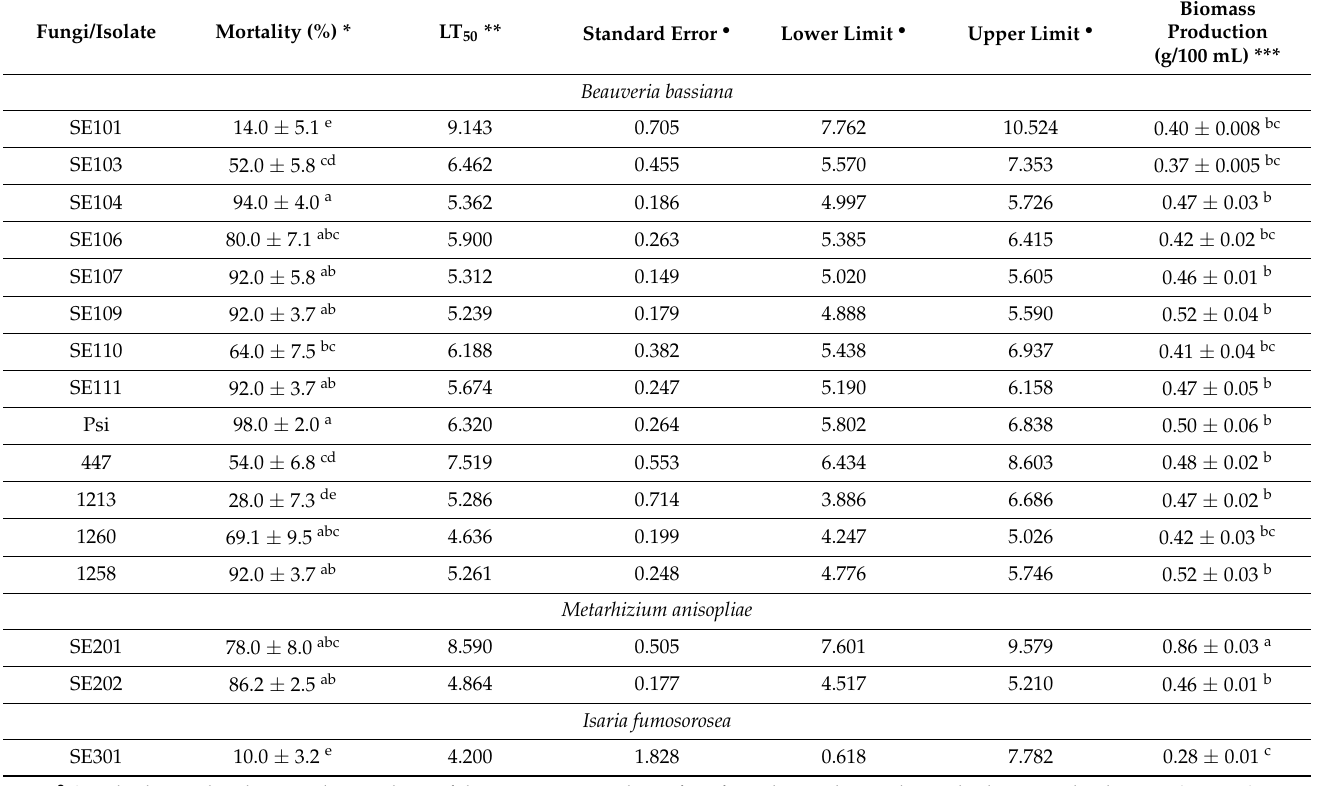
• Standard error, low limit, and upper limit of the LT 50 ; * mean values of confirmed mortality, with standard error and Tukey test ( p < 0.05); ** lethal time 50 (LT 50 )—time estimative (days) necessary for the fungus to cause 50% of confirmed mortality; *** mean values of fungal biomass production with standard error and Tukey test ( p <